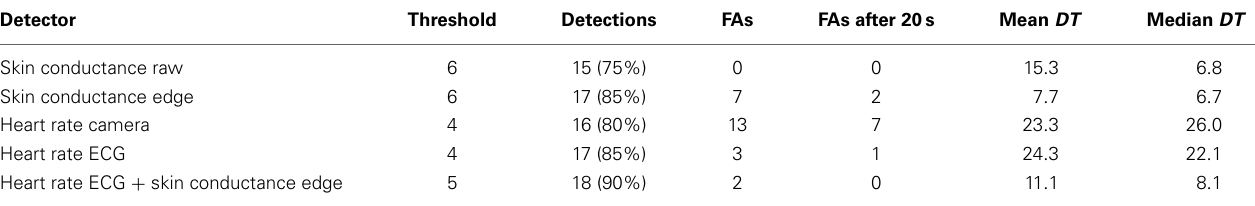
Table 1 | Threshold settings and results for the different stress detectors. Detector